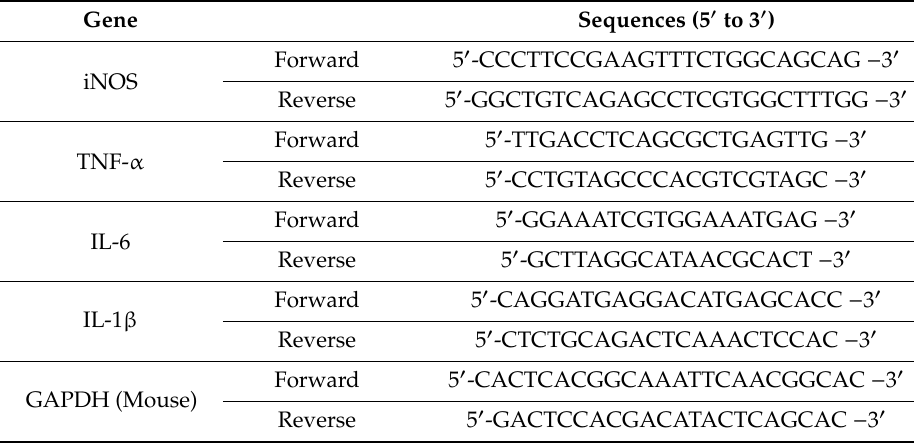
Table 1. Sequences of primers used in RT-PCR